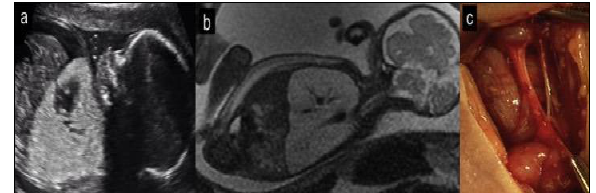
Figure 1: (a) Ultrasound showing large echogenic lungs; the dia- phragm is inverted and there is disproportionately gross ascites. (b) Coronal high-resolution T2- weighted MRI at 35 weeks’ gesta- tion showing markedly distension of both lungs and diaphragmatic inversion. (c) Intra-operatory aspect of the trachea (EXIT): one centimeter below the thyroid cartilage, it consisted of an atretic